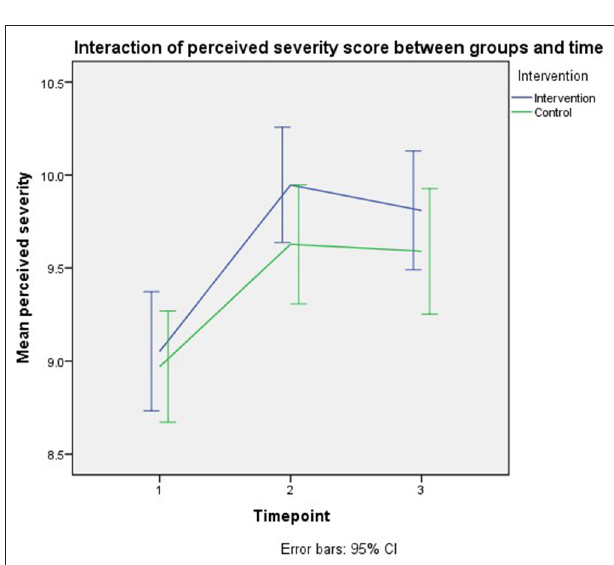
FIGURE 4 | Interaction of perceived severity score between groups and time.